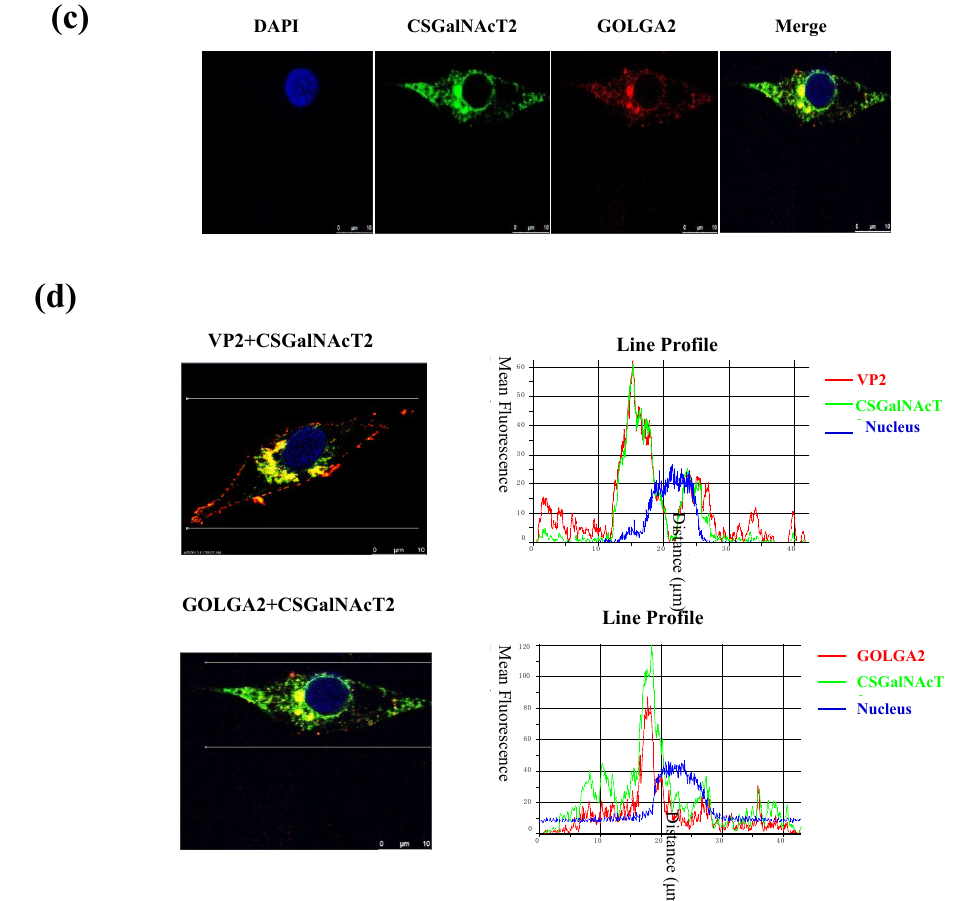
Figure 3. Identification of the interaction of IBDV VP2 and CSGalNAcT2. ( a ) Co-immunoprecipitation of IBDV (Gt) VP2 and exogenous ∆CSGalNAcT2-Flag in DF-1 cells. DF-1 cells were transfected with 4 μg of the indicated plasmids. At 36 h post-transfection, the cell lysates were prepared and immunoprecipitated (IP) with the anti-VP2 monoclonal antibody. VP2 (40 kDa) and ∆CSGalNAcT2-Flag (59 kDa) in the immune complex were detected with the mouse anti-VP2 or anti-Flag antibodies. The light and heavy chains were the component of the anti-Flag antibody used for immunoprecipitation. ( b ) Co-localization of IBDV (Gt) VP2 and CSGalNAcT2. DF1 cells were co-transfected with pCSGalNAcT2 and pGtVP2. Cells were fixed at 36 h post-transfection and subjected to indirect immunofluorescence assay to detect CSGalNAcT2 (green) and VP2 (red), using the mouse anti-Flag and rabbit anti-HA antibodies. The position of the nucleus was indicated by DAPI (blue) staining. ( c ) Exogenous CSGalNAcT2 was expressed and located in the Golgi apparatus, which was marked by the GOLGA2, a Golgi marker. ( d ) Quantitative analysis of the correlation between CSGalNAcT2 and VP2 or GOLGA2, using Image-Pro Plus 6.0 software. The consistent trends between red and green curves indicated that co-localization resulted from a strong correlation in